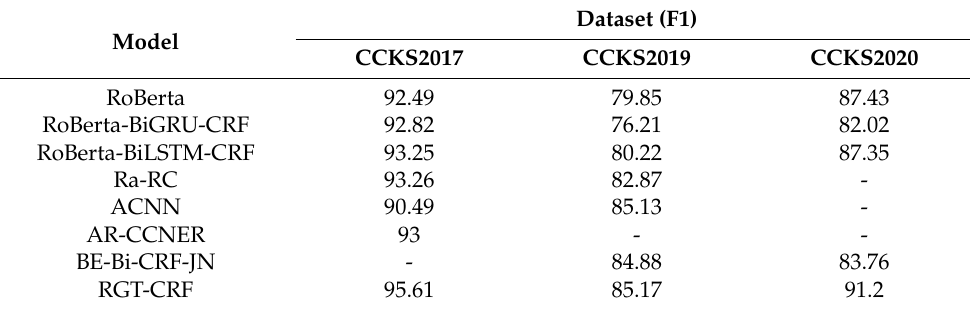
Table 6. Comparison of the results of different F1 of each model on different datasets.